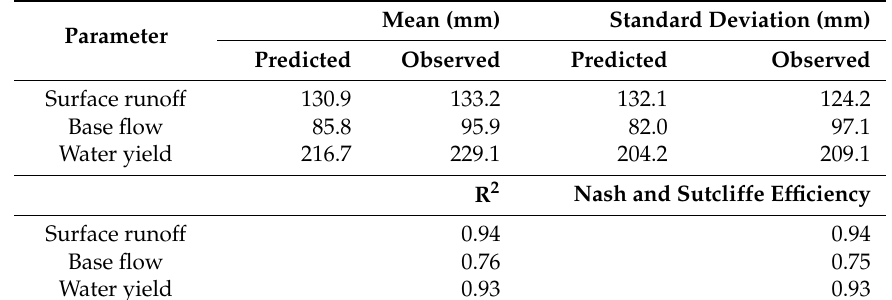
Table 1. Annual average runoff of 8-digit hydrological unit codes (HUCS) in Mississippi River Basin.